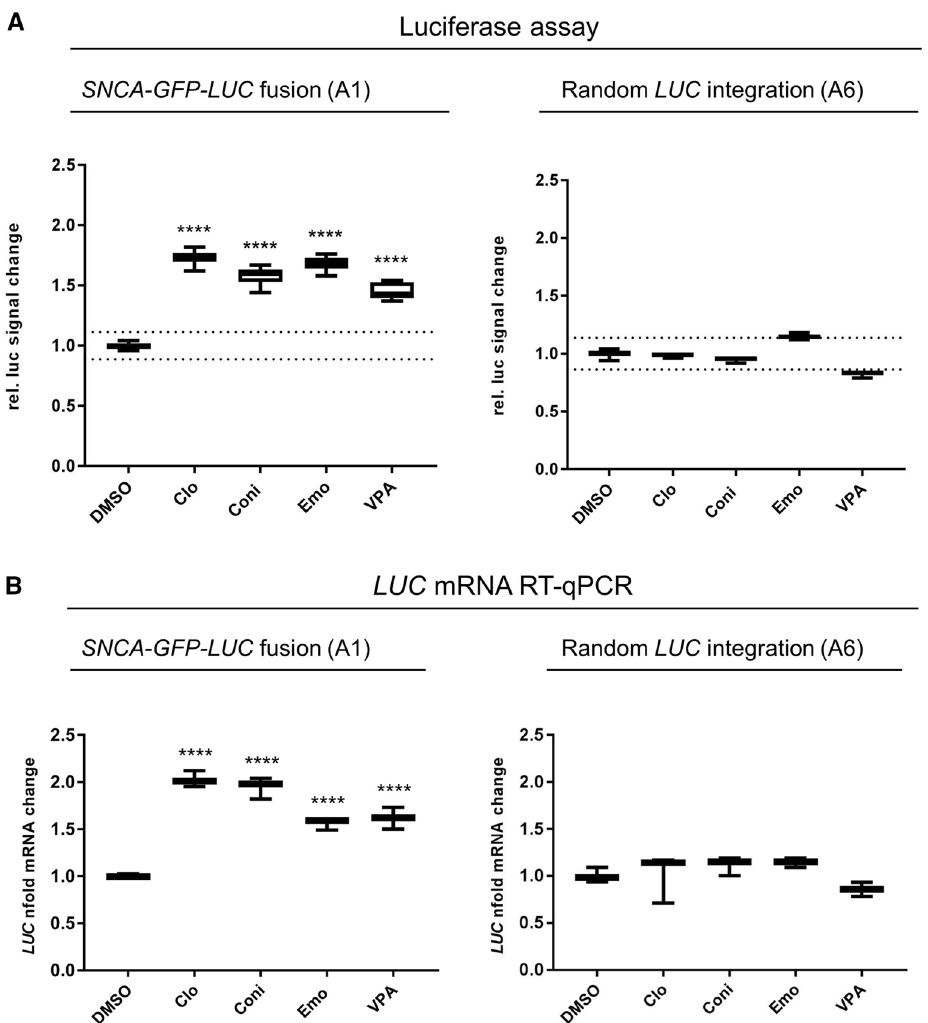
Figure 3. LUC assay and LUC RT-qPCR in the screening (A1) and control cell line (A6) for activators of α-syn. ( A ) Signal fold-change in the LUC assay of A1 and A6 cell lines and ( B ) expression fold changes of LUC mRNA measured with RT-qPCR. LUC signal change was determined by normalizing six replicates of treated cells to DMSO. RT-qPCR data were normalized to three housekeeping genes and DMSO control, in triplicates, respectively. Boxplot diagrams represent 5–95 percentile. Dotted lines in ( A ) depicts threshold of four-fold standard deviation of DMSO control. Compounds were applied at a final concentration of 25 µM (Clo 12.5 µM) for 24 h. VPA was used as a positive control at a concentration of 600 µM. ****p =